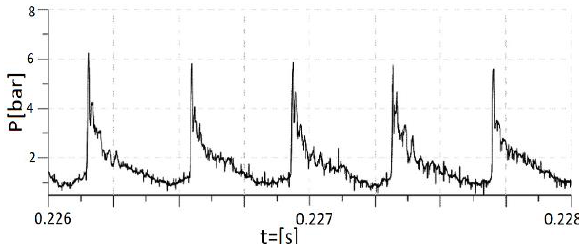
Fig. 5. Pressure variations of stable detonation in the annular chamber [14]